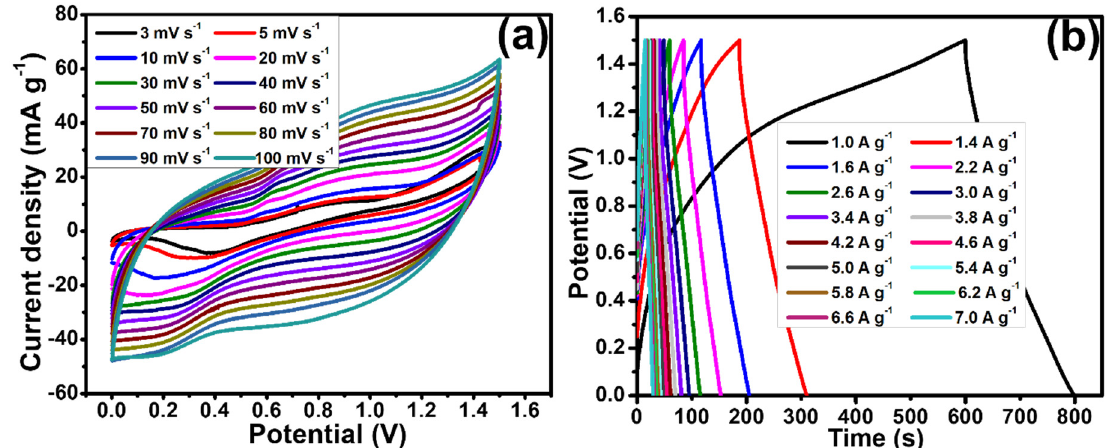
Figure 8. ( a ) CV curves of assembled Ag/GN@PPy − Ni(OH) 2 //AC device assessed in 1 M KOH electrolyte at different scan rates (3 − 100 mV s − 1 ), ( b ) GCD curves at various current densities ranging from 1.0 to 7.0 A g − 1 .